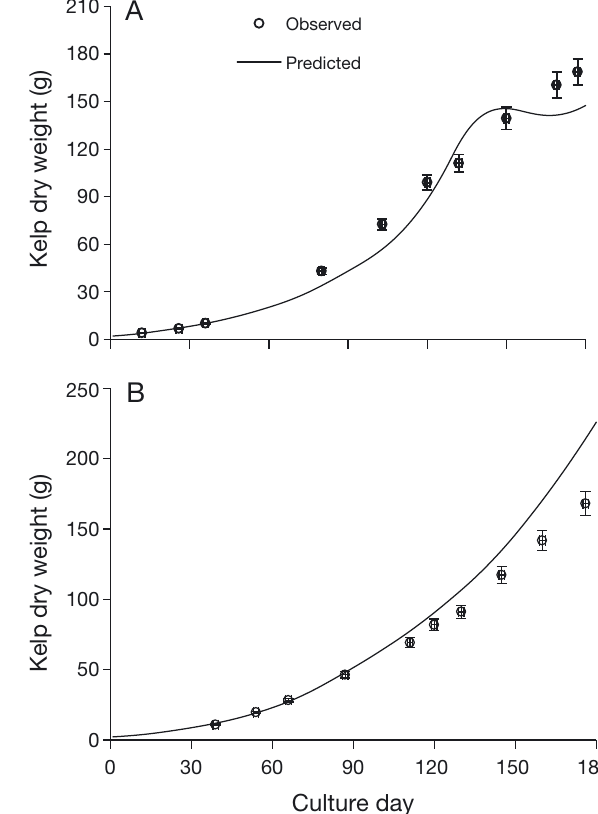
Fig. 4. Comparison of measured and predicted individual dry weight (mean ± SE) of cultured kelp Saccharina japonica in Sanggou Bay, China. (A) 2011−2012, (B) 2008−2009